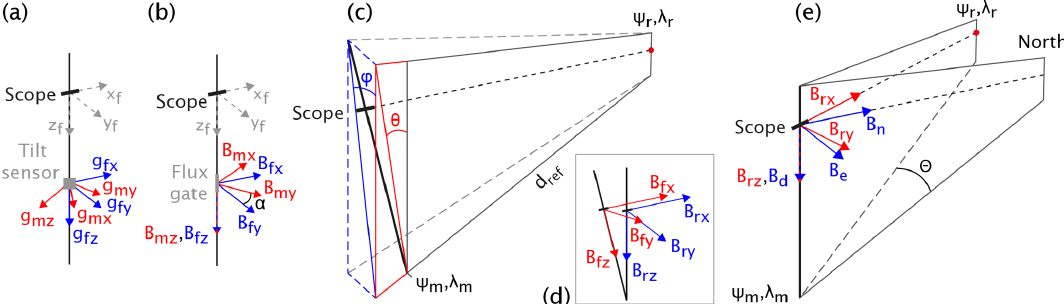
Figure 2. The different coordinate systems of the AnomalyMapper; in each panel the rotations are from the red to the blue coordinate systems. The axes of the tilt sensor ( g m x , g m y , g m z ) are rotated to the axes defined by the frame of the AnomalyMapper ( g f x , g f y , g f z ) (a) , and the axes of the fluxgate ( B m x , B m y , B m z ) are rotated over angle α around the z axes of the AnomalyMapper to B f x , B f y , B f z (b) . Then the tilt sensor measurements are used to rotate the fluxgate measurements in the system of the AnomalyMapper ( B f x , B f y , B f z ) over angles φ and θ to the reference frame, with B r x pointing in the direction of the reference point (red dot; ( (cid:57) r , λ r )); B r y and B r z are vertical (c, d) . The last rotation is over angle (cid:50) (the bearing from the measurement location ( (cid:57) m , λ m ) to the reference point) around the vertical axis to align B r x to geographic north ( B n ) and B r y to geographic east ( B e ) (e)